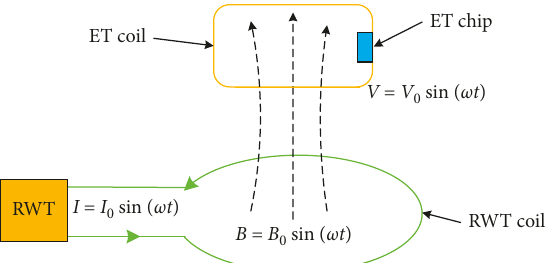
Figure 2: Schematic diagram of the RFID system. RWT, read-write terminal; ET, electronic tag.